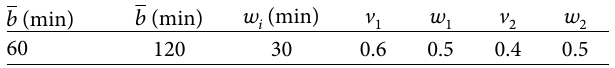
Table 1: Input parameters for the real-world rail example.